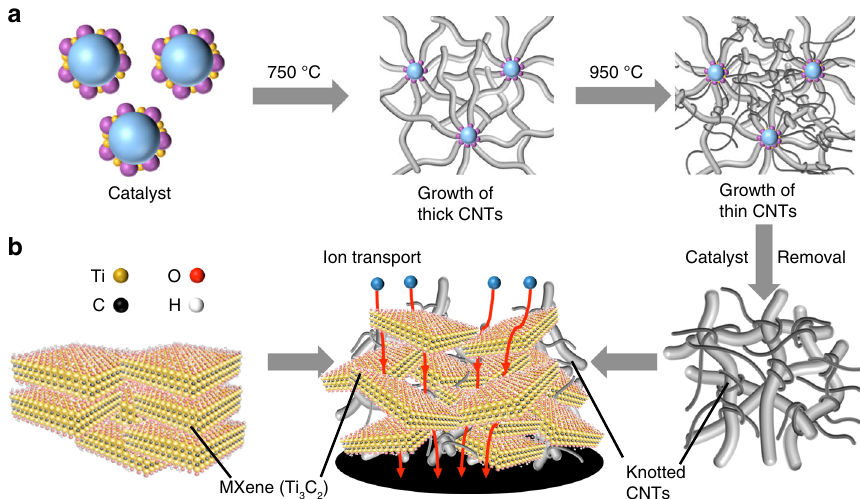
Fig. 1 Design of the MXene-knotted CNT composite electrodes for ef fi cient ion transportation. a Schematic of the synthesis process for the knotted CNTs, where thin CNTs were intertwined with thicker CNTs. b Schematic of a MXene-knotted CNT composite electrode with reduced horizontal orientation and lower ion transport tortuosity through the bulk of the